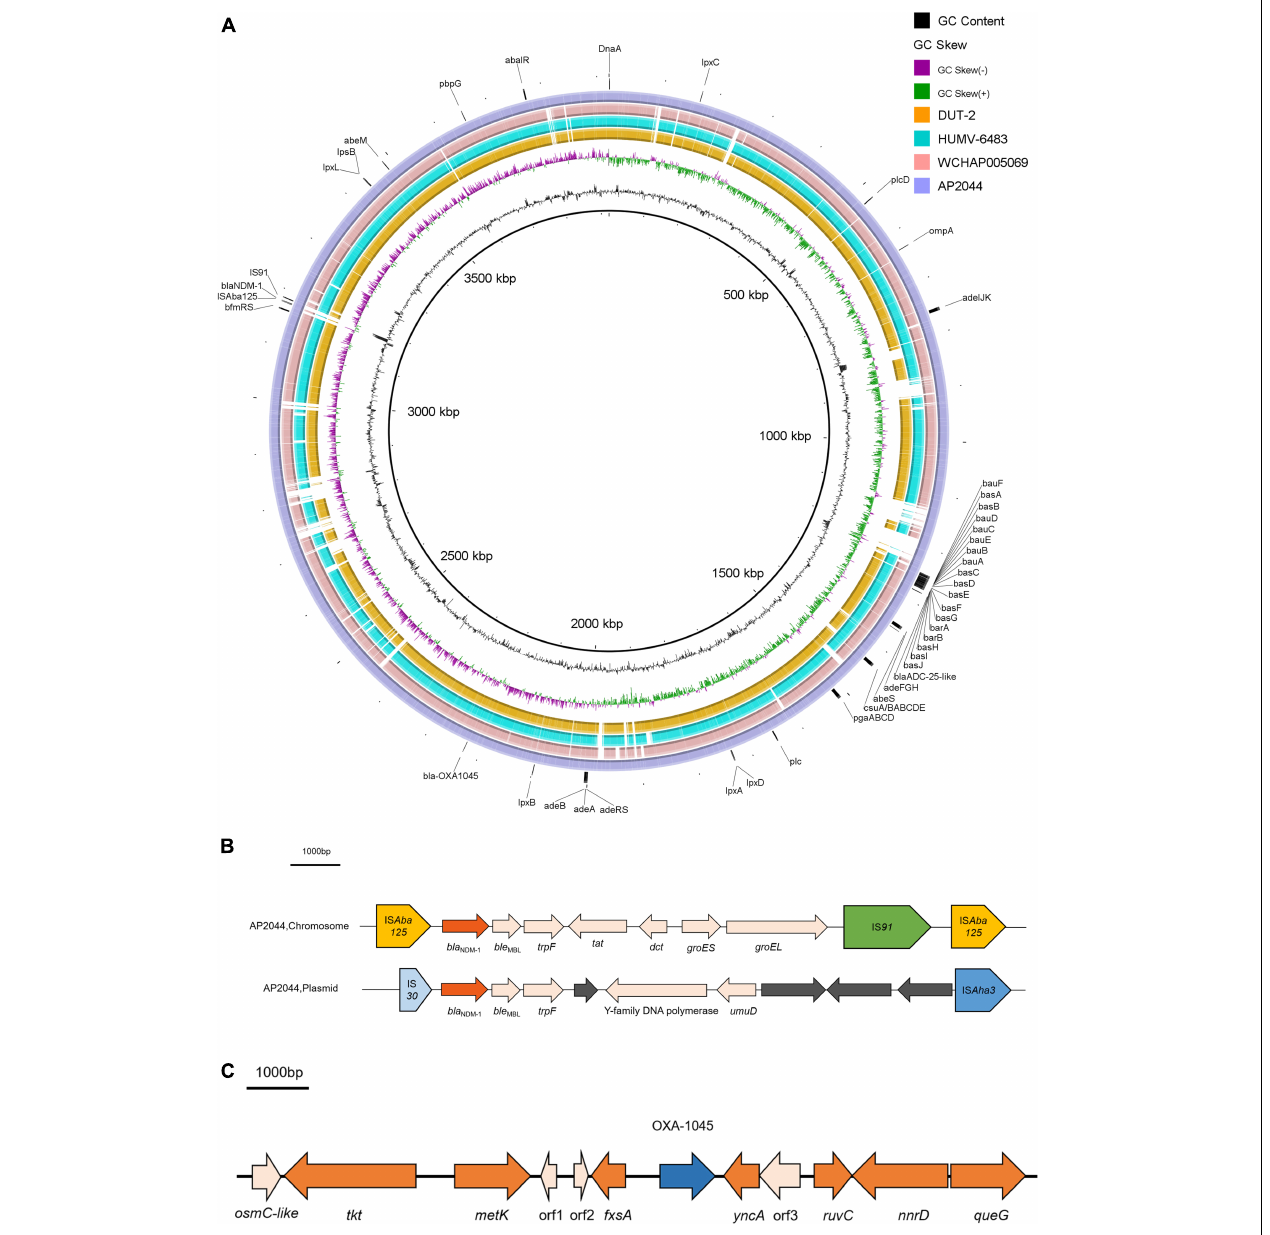
FIGURE 1 | (A) Chromosomal genomic sequence of A. pittii AP2044 strain. Alignment of AP2044 with DUT2, HUMV-6483, and WCHAP005069. AP2044 is the closest to DUT2 (accession no. CP014651.1) and HUMV-6483 (accession no. CP021428.1). HUMV-6483 was recovered in a hospital of a neighboring city (Chengdu, China) in 2018, with an 89% coverage and 96.47% identity. Annotations are provided by ResFinder 1 , IS Finder 4 , and VFDB 5 analysis. (B) Genetic environment of bla NDM - 1 located on chromosome and pAP2044-1 from AP2044 strain. (C) Genetic environment of bla OXA − 1045 from AP2044